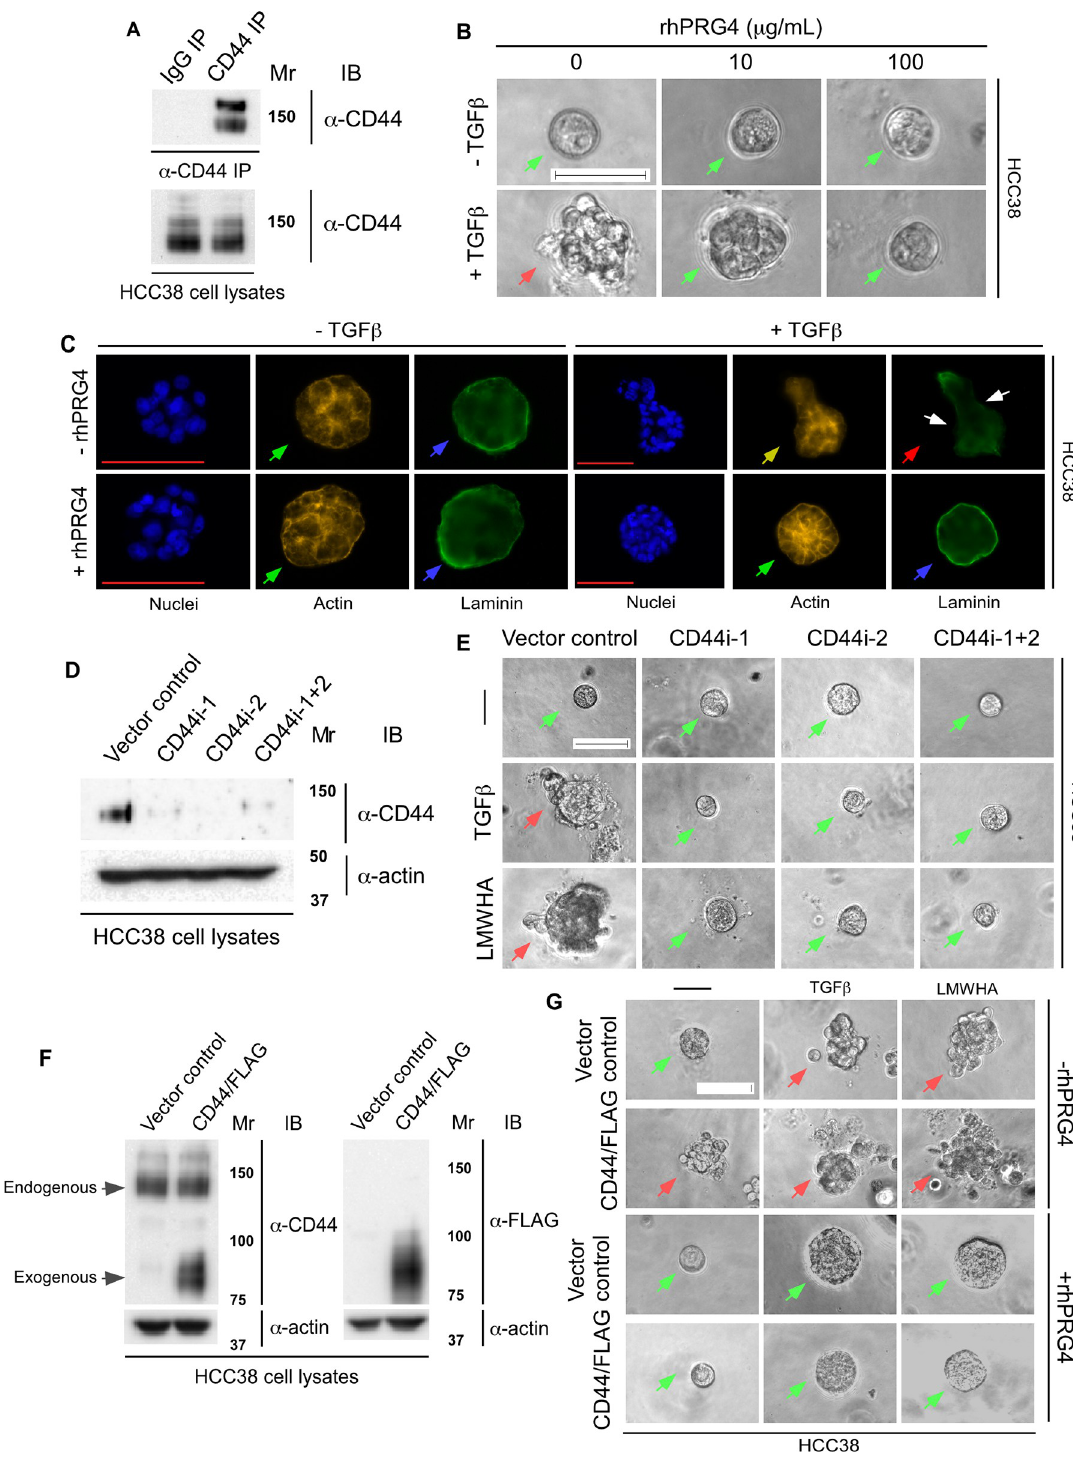
Fig 6. rhPRG4 acts in a CD44-dependent manner to supress TGF β - or LMWHA-induced invasive growth of HCC38. (A) Lysates of HCC38 cells were subjected to immunoprecipitation using a mouse CD44 antibody (CD44 IP) or a non-specific mouse IgG antibody (IgG IP) followed by CD44 immunoblotting. The protein abundance of CD44 in the lysates was confirmed by CD44 immunoblotting. (B) Representative DIC light microscopy images of 6-day old three-dimensional HCC38 cell-derived organoids that were left untreated or incubated with 100 pM TGF β , without or with increasing concentrations of rhPRG4 (10 and 100 μ g/mL) in complete growth